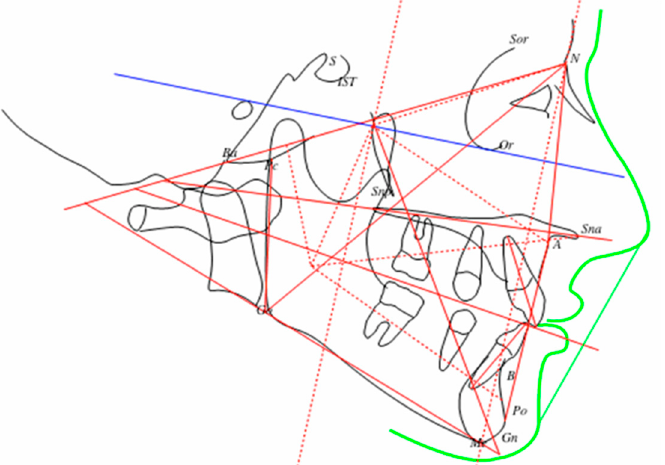
Figure 2. Linear and angular measurements on a lateral cephalogram: distance S-N , distance Ba-S , distance from Snp to A , distance Snp-Sna , distance Go-Me , distance SOR-Sna , distance Sna-Me , Wit’s index, SNA , SNB , ANB (Steiner). Intermaxillary angle: SnaSnp-GoMe . Cranio-mandibular angle: SN-GoMe . Cranio-maxillary angle: SN-SnaSnp .